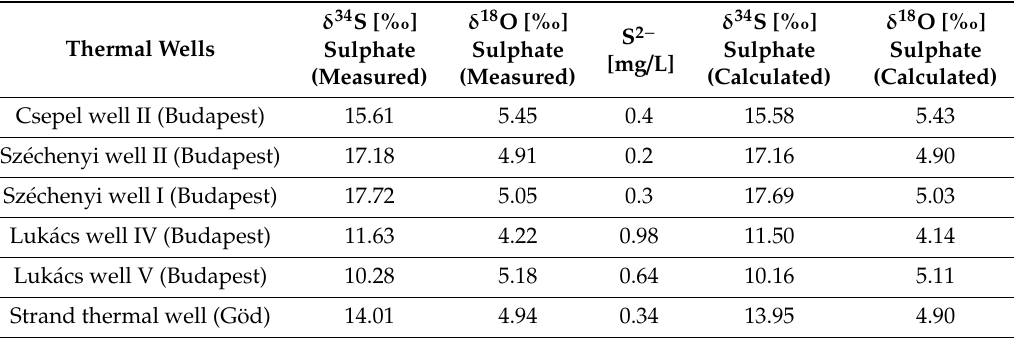
Table 4. The calculated δ 18 O and δ 34 S values of bisulphate before bacterial reduction in six sulphate samples. The enrichment factors we used in this calculation are ε 34S = 70% (cid:24) and ε 18O = 20% (cid:24) . The / ε ε 34S 18O ratio is 3.5, which is the mean value of the range 2.5–4.5 defined by Fritz et al. (1989) [29]. Thermal Wells